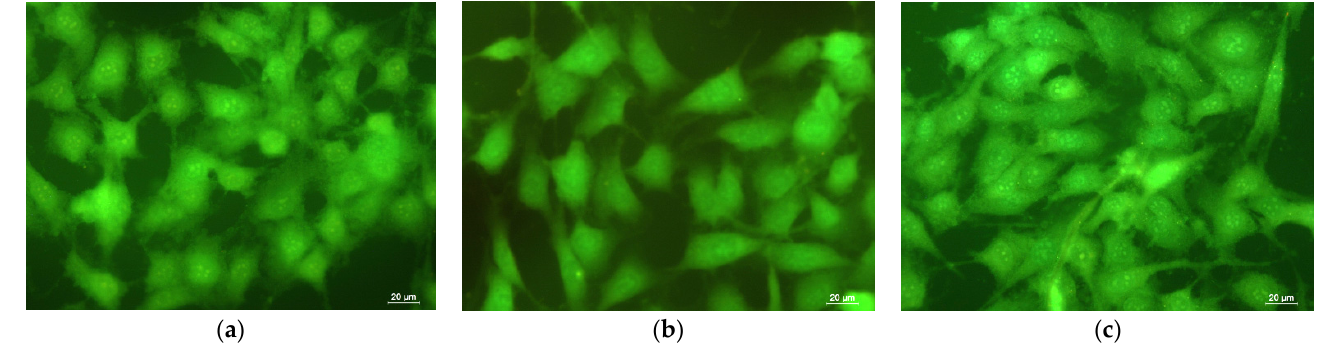
Figure 7. Fluorescence micrographs of AO and EtBr double-stained mouse BALB/c 3T3 fibroblast cells incubated for 24 h: ( a ) untreated cells; ( b ) PLA mat; and ( c ) PLA/ P. oleracea mat. Live cells are shown in green . Bar: 20 μ m.